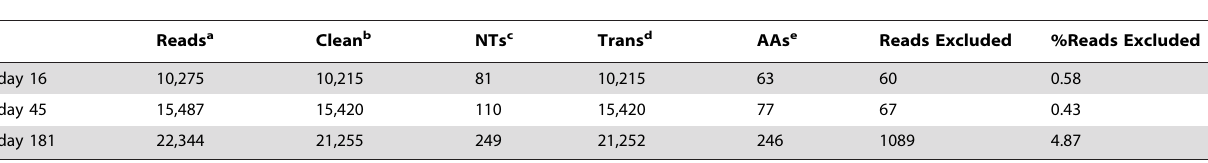
Table 2. 454 pyrosequencing sequence